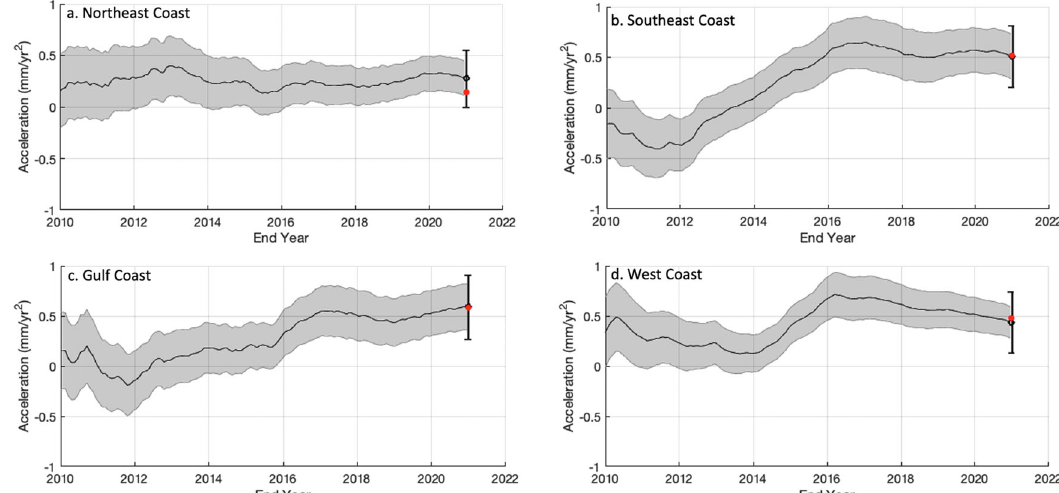
Fig. 4 Evolution of altimeter acceleration. For the time-period from 1993 to 2020, the evolution of acceleration estimates from the satellite altimeter record for four different regions along the coastlines of the United States: ( a ) Northeast Coast, ( b ) Southeast Coast, ( c ) Gulf Coast, ( d ) West Coast. The start year for each estimate is 1993, and the end year for the estimate is given on the x-axis. The shading provides the 90% con fi dence interval. The corresponding tide gauge estimates from 1993 to 2020 are shown in red, and the tide gauge envelope of possible estimates is provided by the solid black error bar.